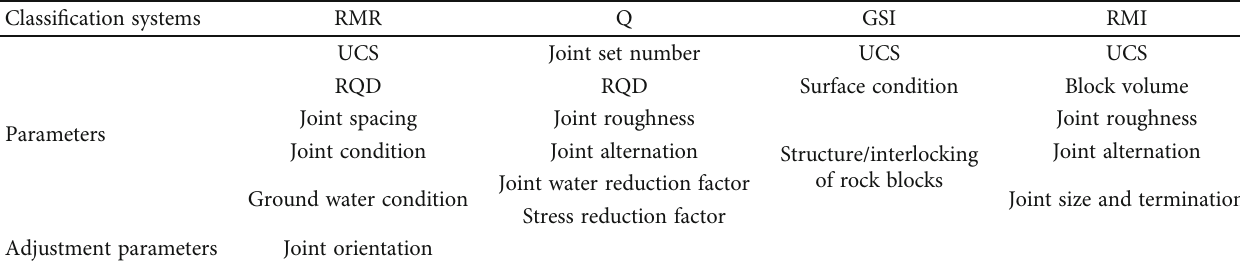
Table 1: Parameters to consider for the di ff erent classi fi cation systems [37].